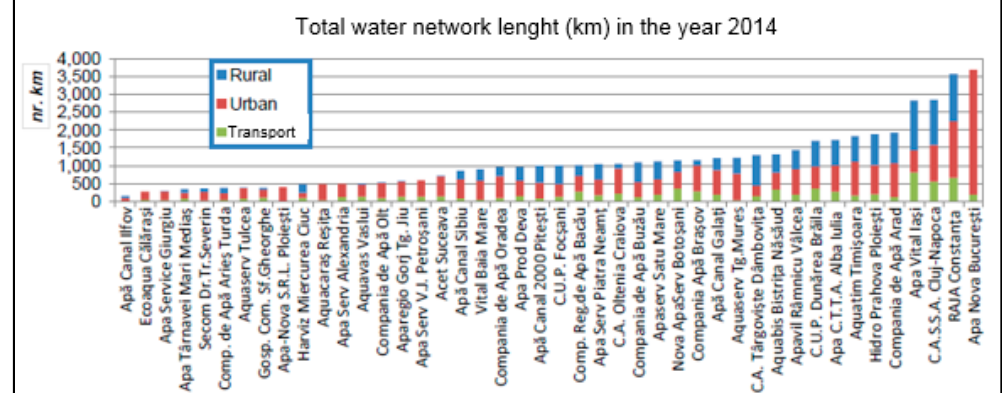
Figure 1. Length of the water supply systems for each water utility in 2014